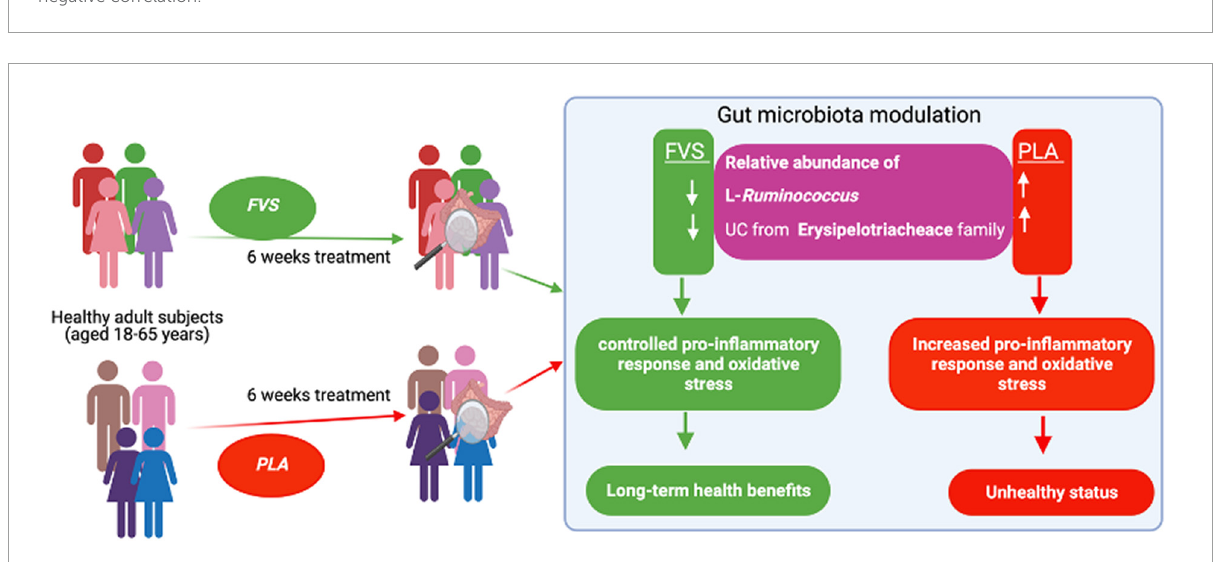
FIGURE9 Schematic representation of the gut microbiota modulation by the FVS on healthy